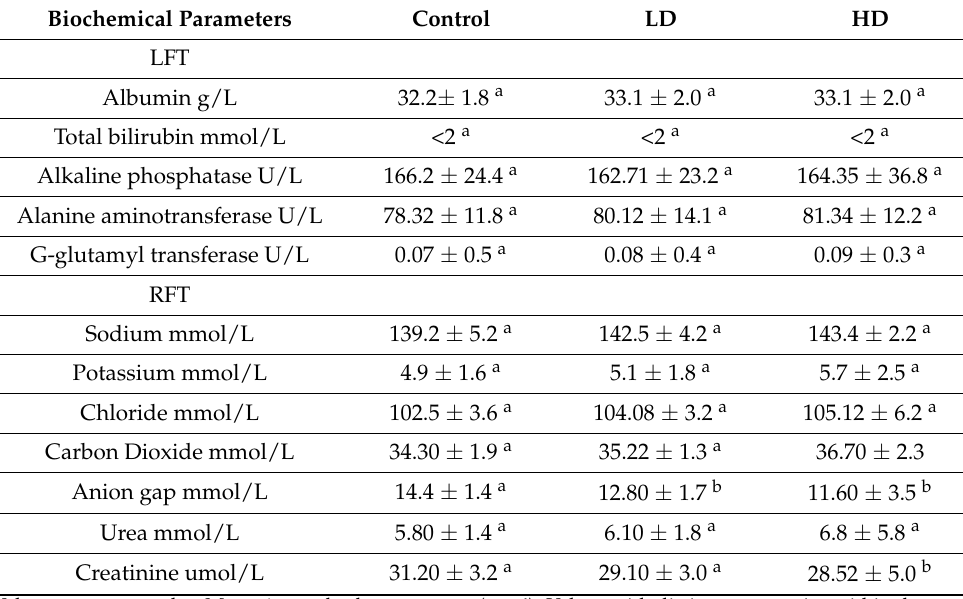
Table 2. Influence of OME on the biochemistry of experimental rats in acute toxicity test. Biochemical Parameters